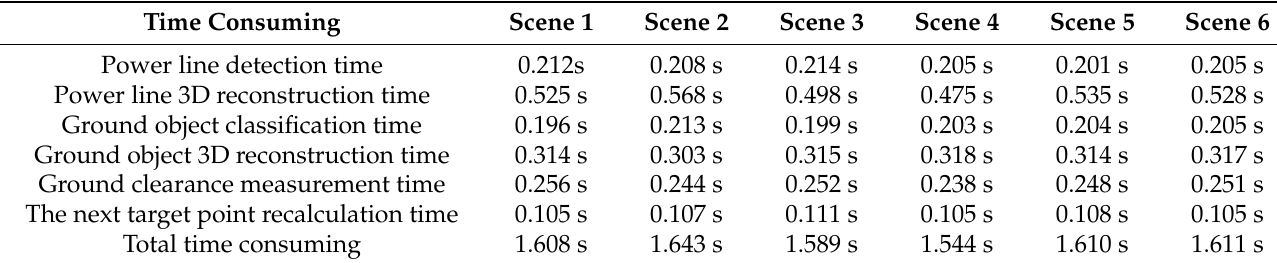
Table 6. The time of different information processing stages required to reconstruct the six scenes in Figure